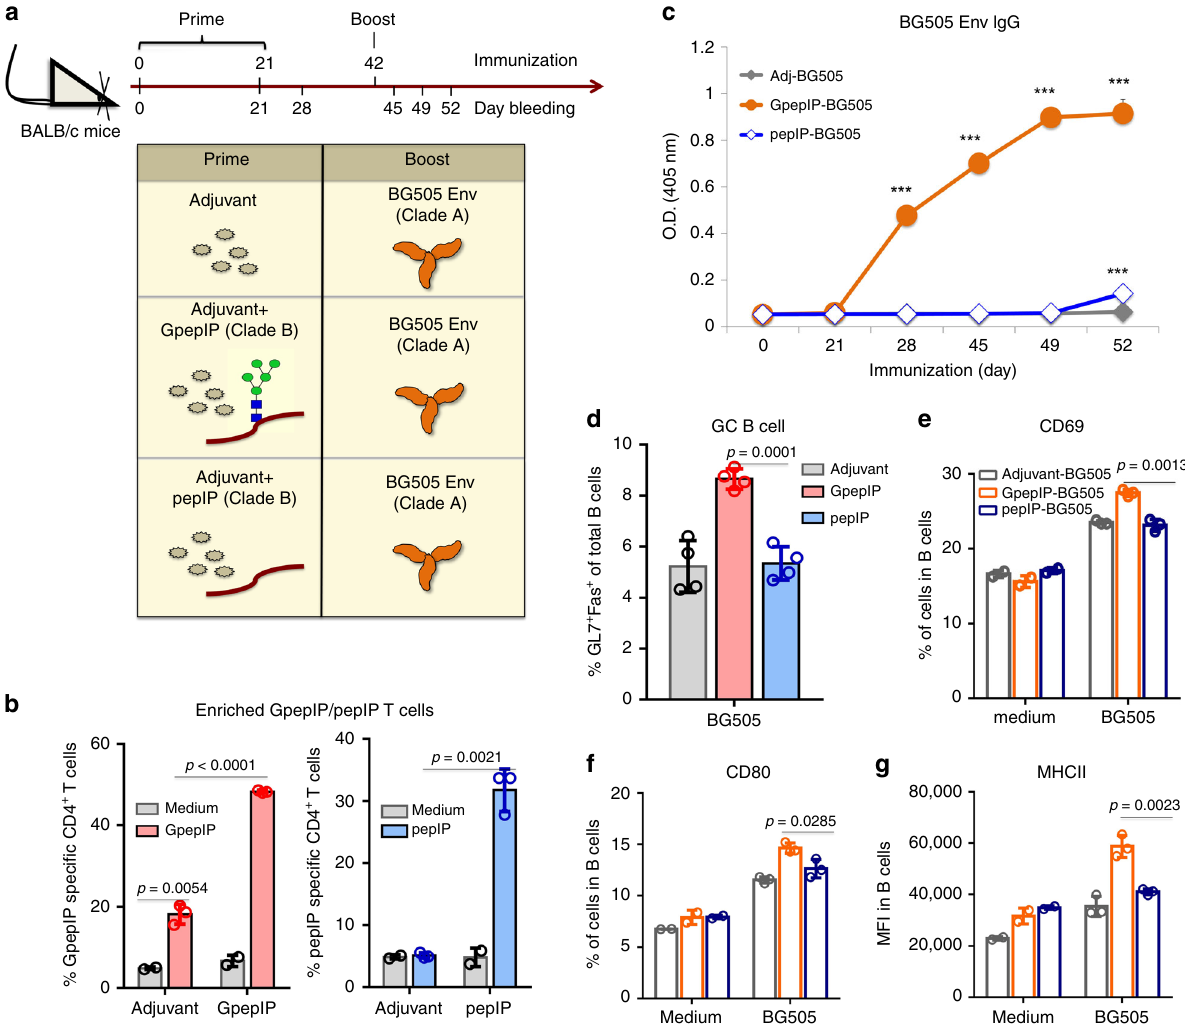
Fig. 6 GpepIP-speci fi c CD4 + T cells exhibit high potency on helping humoral immune responses to HIV-1 trimer. a Immunization scheme. BALB/c mice were primed twice by subcutaneous injection of GpepIP or pepIP emulsi fi ed in Freund ’ s adjuvant or of adjuvant alone. Three weeks later, all groups were immunized with the clade A BG505 gp140 NFL trimer emulsi fi ed in incomplete Freund ’ s adjuvant. Sera were collected at the indicated time points. Mice were euthanized 10 days after trimer immunization. b Splenic and lymph node cells were isolated and stimulated with GpepIP or pepIP in vitro for 5 days. T cell proliferation by CFSE dilution was measured by fl ow cytometry. c BG505-speci fi c IgG production was examined in all three groups across the indicated time points by ELISA using a serum dilution 1:100. d GC response, de fi ned by the percentage of GL7 + Fas + B cells among B220 + B cells, was evaluated in all three groups on day 10 after trimer immunization by fl ow cytometry. e – g Expression levels of activation marker CD69 e , CD80 f , and MHCII g were detected on splenic B cells after in vitro stimulation with the BG505 trimer for 3 days. MFI mean fl uorescence intensity. Representative results are shown from one of three independent experiments performed. (mean ± s.d.). b medium n = 2; GpepIP or pepIP n = 3 independent experiments. d n = 4 independent experiments. e – g medium n = 2; BG505 n = 3 independent experiments. P -values were determined using Student ’ s two-sided t -tests. Source data are provided as a Source Data fi